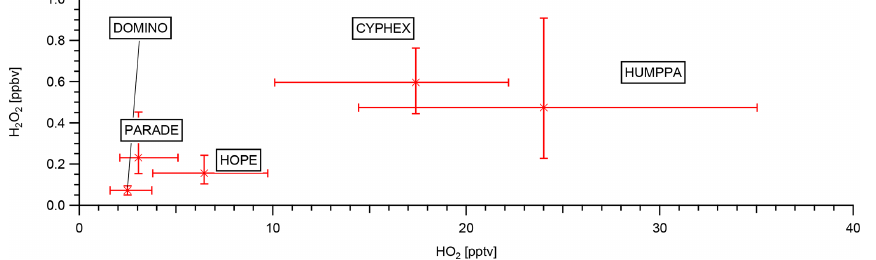
Figure 3. Relationship between H 2 O 2 and HO 2 for the five campaigns. Note that only daytime values (JNO 2 >10 − 3 s − 1 ) have been used for the calculation of the median values and the 25%–75%